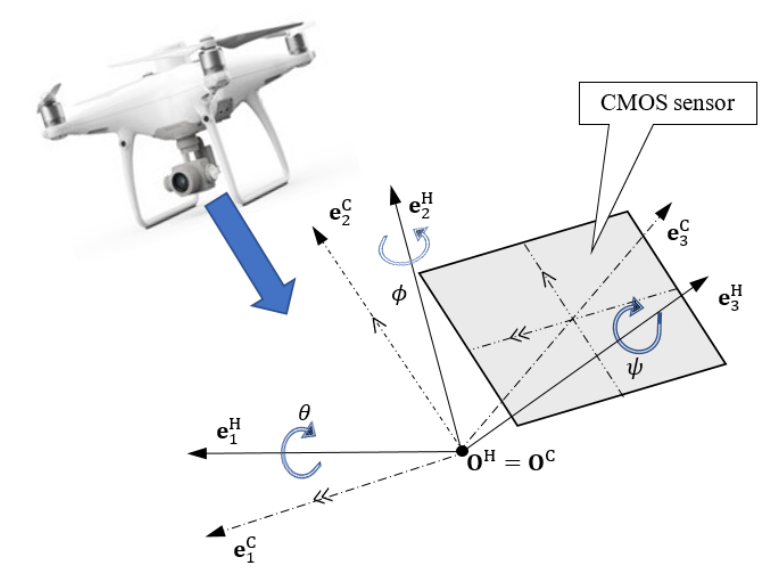
(cid:0) (cid:1) e H , e H , e H and 2 3 1